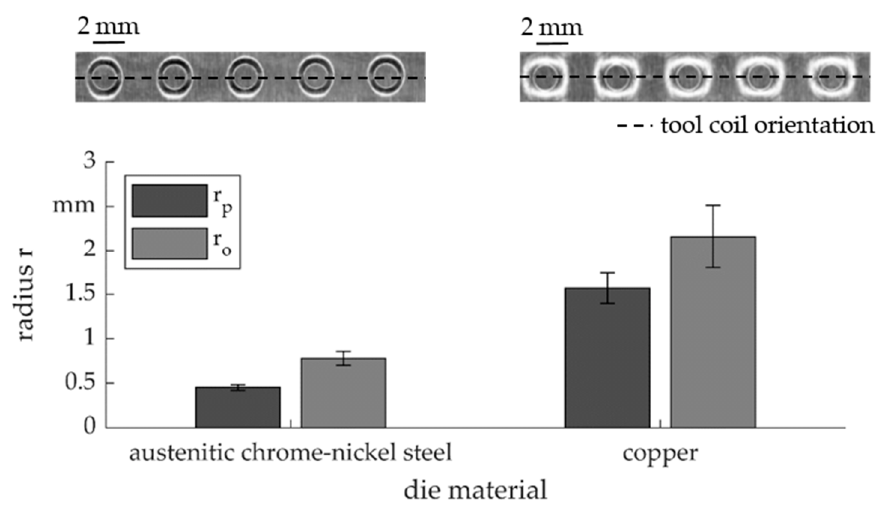
Figure 15. Comparison of the inner corner radius in two directions and the embossing result of two embossing dies made of austenitic chrome-nickel steel and copper, cf. [25].